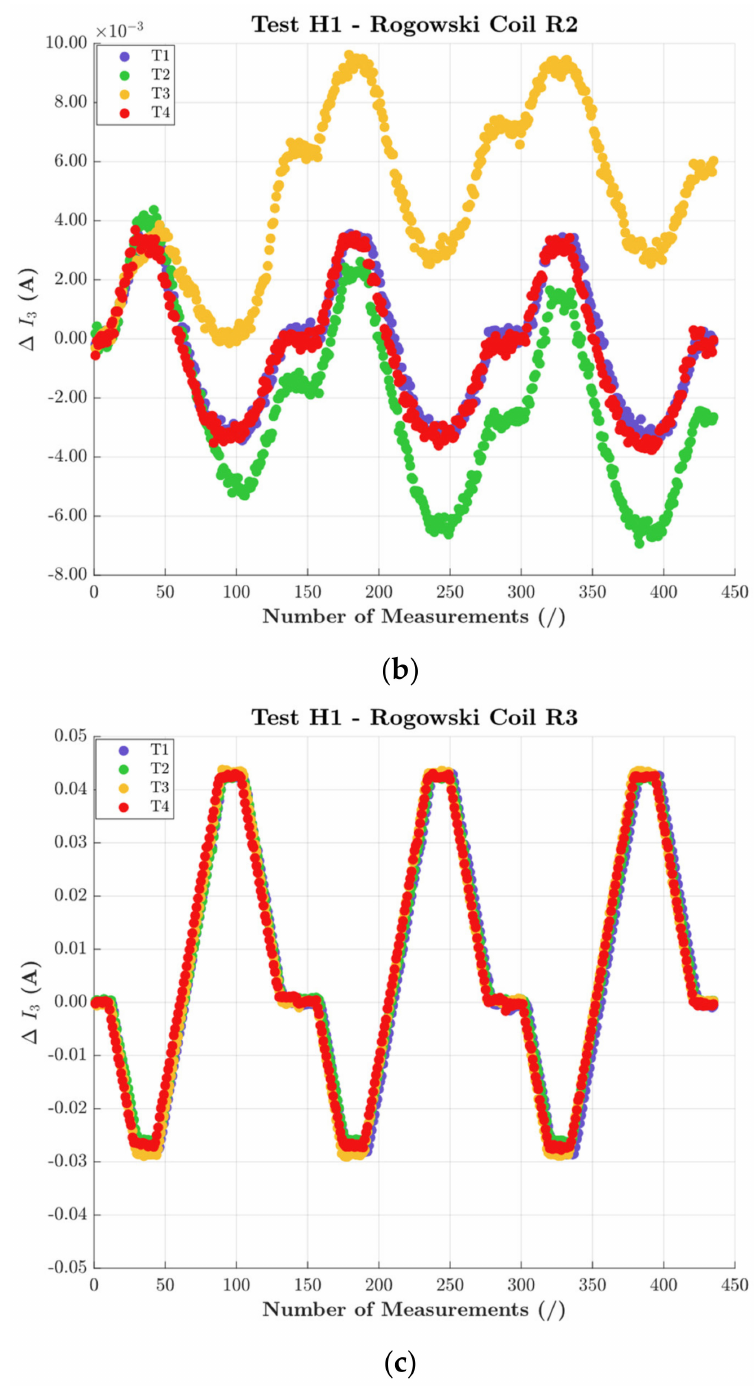
Figure 9. Third harmonic from tests with H1 and all positions, for ( a ) R1, ( b ) R2, and ( c ) R3. The first comment is a comparison with Figures 7 and 8. Whereas from THD it is not possible to appreciate the presence of influence quantities affecting the RC, the opposite is true focusing on a single harmonic. Note the behavior of the third harmonic for all RCs strictly followed the temperature and humidity variations. Furthermore, the positioning affected R1 (T4) and R2 (T3), while R3 was insensitive to all positions. Quantifying the variations, 10 mA, 10 mA, and 45 mA were observed for R1, R2, and R3,